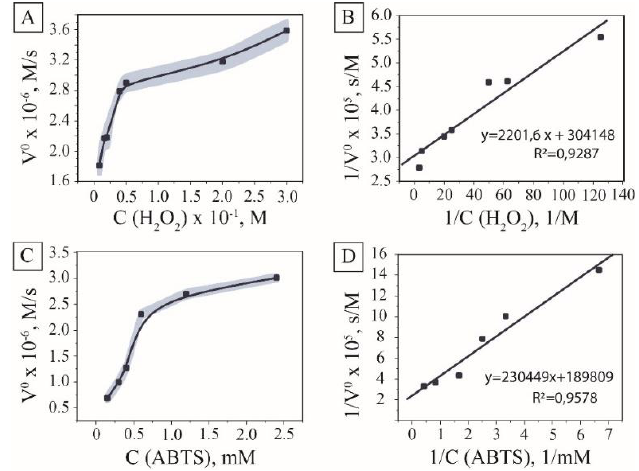
Figure 3. Peroxidase-like activity of MNPs. The kinetic curve and the double reciprocal plots of peroxidase activity at the constant concentration of H 2 O 2 ( A , B ); the kinetic curve and the double reciprocal plots of peroxidase activity at the constant concentration of 2,2 (cid:48) -azino-bis(3-ethylbenzothiazoline-6-sulphonic acid) (ABTS) ( C , D ).